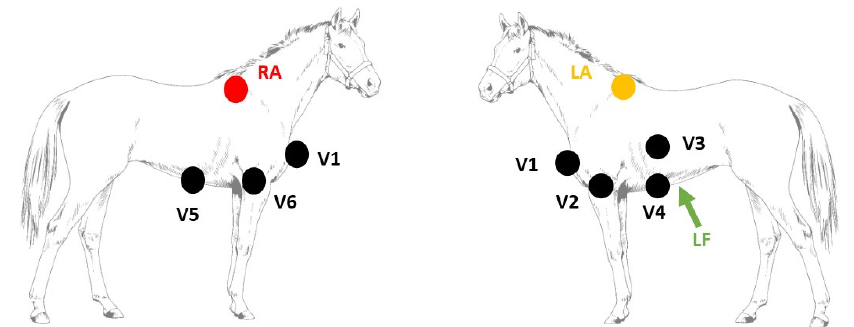
Figure 1. Electrode placement to record the 12-lead electrocardiogram. Abbreviations: LA, left arm electrode; LF, left foot electrode; RA, right arm electrode; V, precordial